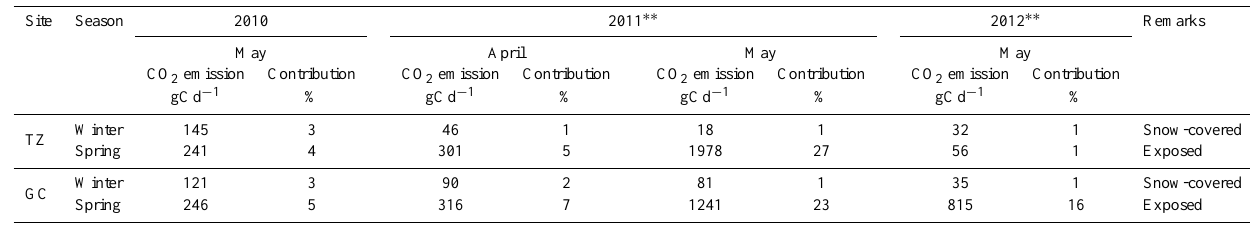
Table 5. Contributions (%) from seasonal CO 2 emission contributions to the annual carbon budget, on the basis of a constant area (400m 2 ) for the white spruce forest TZ and GC sites during the period 2010–2012 ∗ .